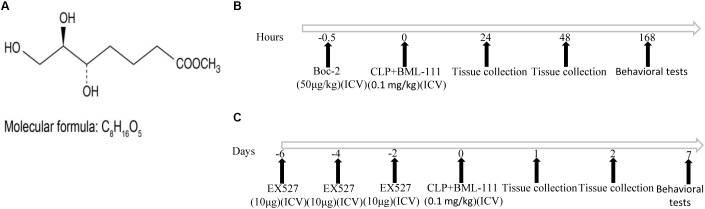
Molecular formula and structure of BML-111 (A) and a schematic representation of the experiments (B,C).